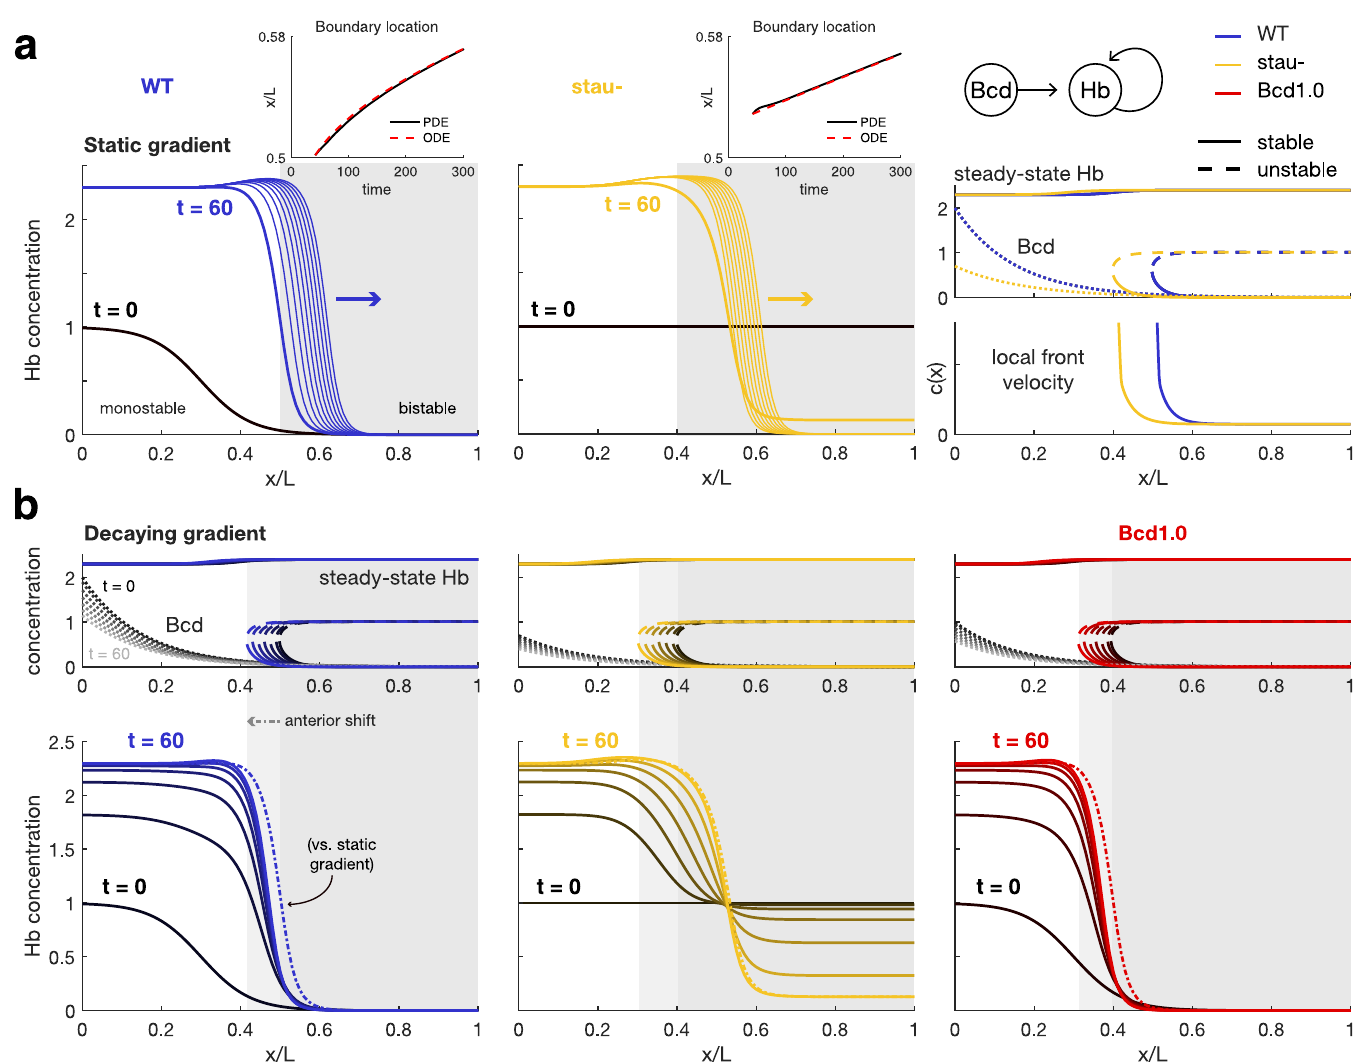
Fig 4. (a) In the posterior of the embryo, the Hb boundary behaves as a bistable propagating wavefront . Simulations (left, middle) and bifurcation diagrams (right) of the Hb patterning system with a static Bcd gradient show that the Hb gene expression boundary becomes a propagating bistable wavefront toward the posterior of the embryo (gray shaded region) and would continue to propagate slowly thereafter (thin lines) if not for external influences such as downstream genetic networks, cellularization, or gastrulation. Blue indicates wild-type (WT) and gold, stau - mutant. Right, the Bcd gradient for stau - (gold dotted line) has lower amplitude than that of the WT Bcd gradient (blue dotted line), which shifts the bifurcation (critical) point anteriorly. The local front velocity calculated from Eq (13) rapidly decreases posterior to the critical point but remains strictly positive, indicating that a bistable gene expression boundary will propagate posteriorly. The Bcd1.0 bifurcation diagram (see (b)) is almost identical to that of stau - . Top insets compare boundary location from PDE simulations (solid black) to the location from an ODE approximation (red dashed) derived from the local front velocities, with � equal to a quarter of the boundary width. Simulation start t = 0 is 10 min before the beginning of nc14. (b) Decay in the Bcd gradient shifts the bistable region anteriorly over time, causing boundaries to stabilize at slightly anterior positions . Bottom, there is a greater discrepancy between boundaries forming over dynamic (solid lines) vs. static (dash-dot line) in the WT (blue) and Bcd1.0 (red) mutant than the stau - (gold) mutant due to differences in front emergence. Specifically, homogeneous initial conditions below the maximum value of the unstable steady state cause the boundary in the stau - mutant to appear within the bistable region, such that boundary propagation continues at roughly the same speed regardless of gradient dynamics. In contrast, in WT and Bcd1.0 the boundary is preinduced anterior to the critical point. A decrease in morphogen concentration in time causes the boundary to reach the critical point sooner, but also reduces the total time spent by the boundary in the region of rapid propagation, resulting in more anterior placement relative to the static case. All parameters are as given in [40].